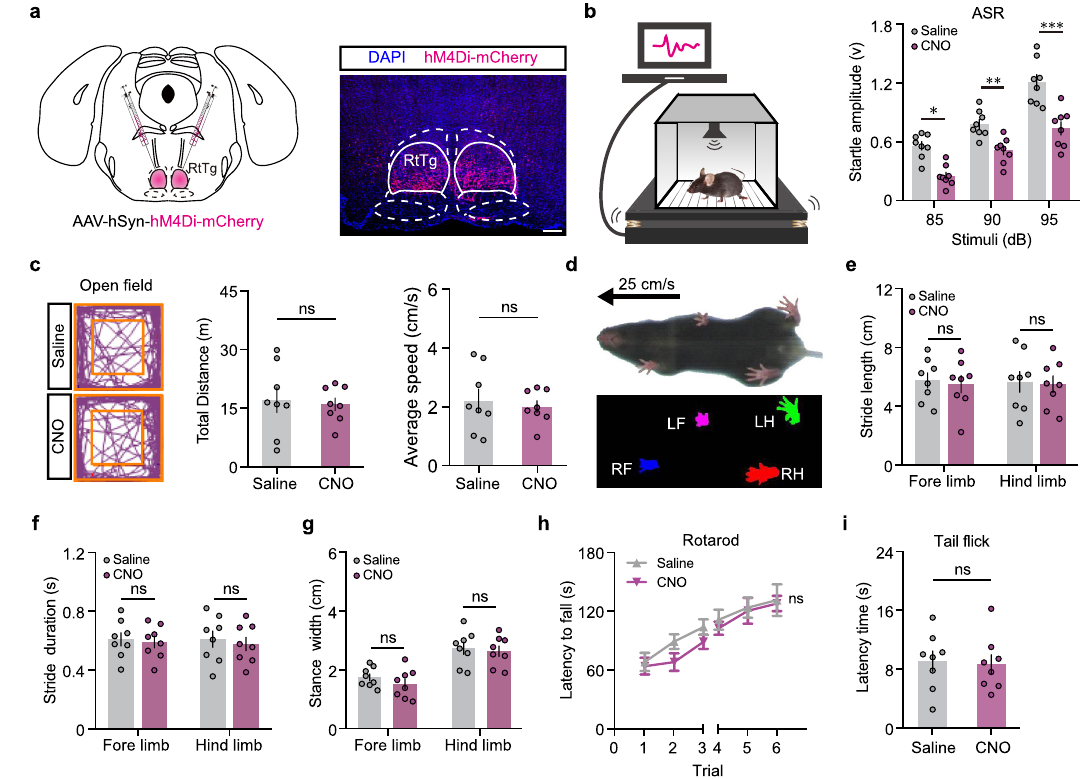
Fig. 2 Behavioural consequences of RtTg inactivation. a Left: schematic for chemogenetic inactivation of RtTg neurons. Right: a representative image con fi rming hM4Di-mCherry expression. Scale bar, 300 μ m. b Left: schematic for the ASR paradigm. Right: quantitative graph showing the effect of RtTg inactivation on ASR amplitudes ( n = 8 per group; t = 2.417, P = 0.02 (85 dB); t = 3.429, P = 0.0014 (90 dB); t = 5.976, P = 4.3 × 10 − 7 (95 dB)). c Left: representative movement tracks of hM4Di-infected mice after i.p. injection of saline or CNO. Quanti fi cation of total distances (middle, n = 8 per group; P = 0.7637) and average speed (right, n = 8 per group; P = 0.6411) during open fi eld test. d Representative images showing a mouse walking on treadmill and paw prints detected from a video settled under the treadmill. e – g Digi Gait analysis for hM4Di infected mice after i.p. injection of saline or CNO ( n = 8 per group; for e: t = 0.2945, P = 0.7705 (fore limb); t = 0.1914, P = 0.8496 (hindlimb); for f: t = 0.2689, P = 0.7899 (fore limb); t = 0.4781, P = 0.6363 (hindlimb); for g: t = 0.9117, P = 0.3697 (fore limb); t = 0.4126, P = 0.6831 (hindlimb)). h Latency to fall on accelerating rotarod of hM4Di-infected mice after i.p. injection of saline or CNO ( n = 8 per group; F = 0.2, P = 0.9346). i Tail- fl ick latency of hM4Di-infected mice after i.p. injection of saline or CNO ( n = 8 per group, P = 0.8269). Error bar represent mean ± s.e.m. Signi fi cance was assessed using two-sided unpaired t- tests in c,i, and two-way ANOVA combining with FDR corrections in b , e – h . * P < 0.05; ** P < 0.01; *** P < 0.001; ns, not signi fi